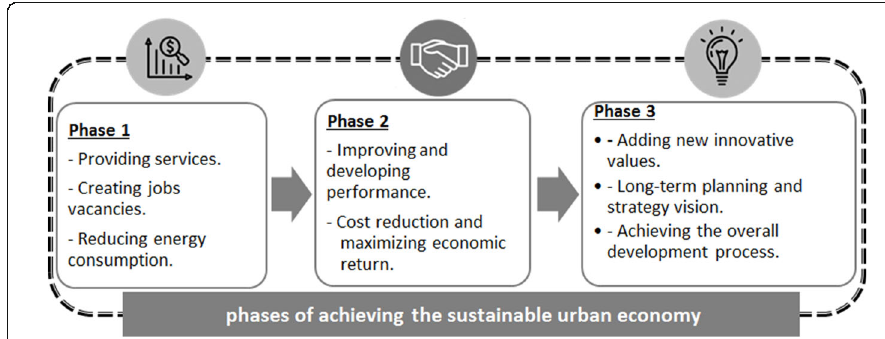
Fig. 1 Phases of achieving economic sustainability. Source: Author, based on